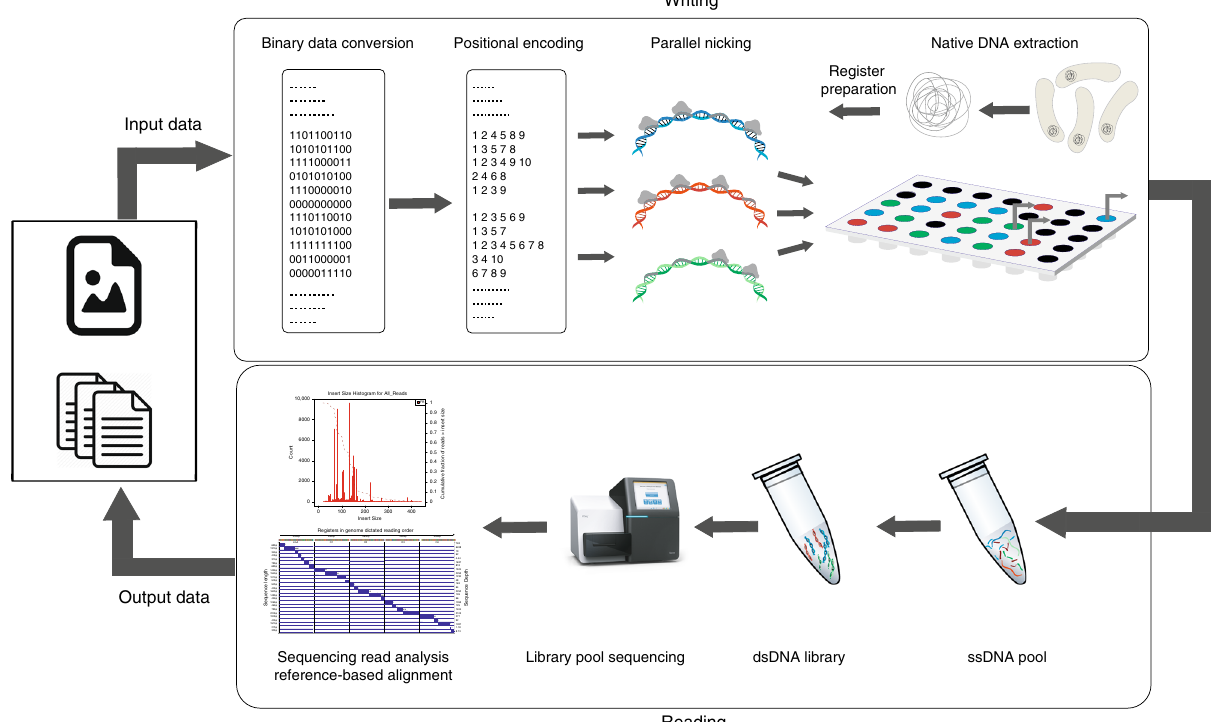
Fig. 1 The native DNA-based data storage platform. In the Write component, arbitrary user content is converted into a binary message. The message is then parsed into blocks of m bits, where m corresponds to the number of nicking positions on the register (for the running example, m = 10). Different (orthogonal) registers may be used to encode information in parallel, as indicated by the different colors of the DNA strings. Subsequently, binary information is translated into positional information indicating where to nick. Nicking reactions are performed in parallel via combinations of Pf Ago and guides. In the Read component, nicked products are puri fi ed and denatured to obtain a pool of ssDNAs of different lengths. The pool of ssDNAs is sequenced via MiSeq either as part of an orthogonal register mixture or individually. The output reads are processed by fi rst performing reference-based alignment of the reads, and then using read coverages to determine the nicked